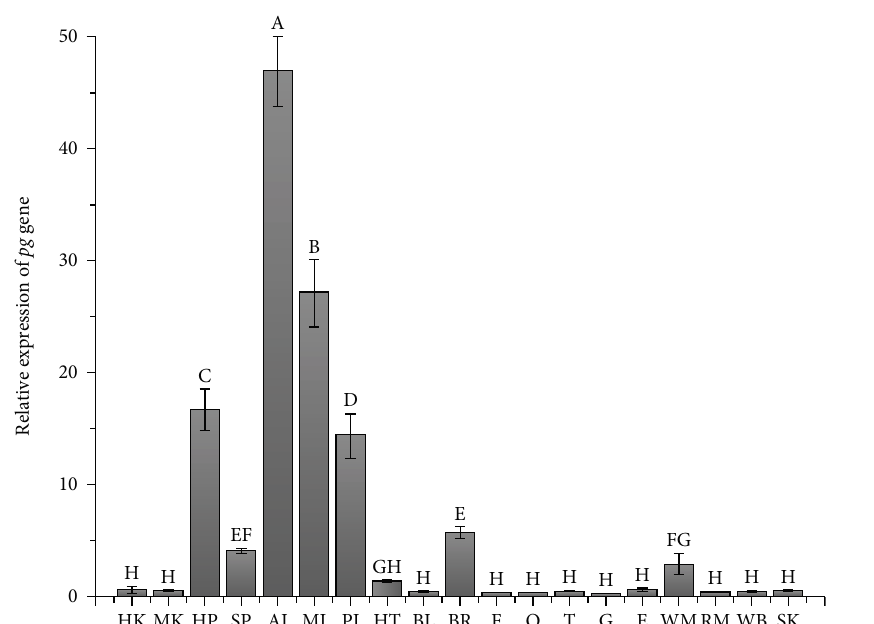
Figure 2: Tissue distribution of pg gene in adult S. denticulatus under normal condition. HK: head kidney; MK: middle kidney; HP: hepatopancreas; SP: spleen; AI: anterior intestine; MI: middle intestine; PI: posterior intestine; HT: heart; BL: swimming bladder; BR: brain; F: fi n; O: ovary; T: testis; G: gill; E: eye; WM: white muscle; RM: red muscle; WB: whole blood; SK: skin. Di ff erent uppercase letters on bars indicate signi fi cant di ff erences ( P < 0 : 05